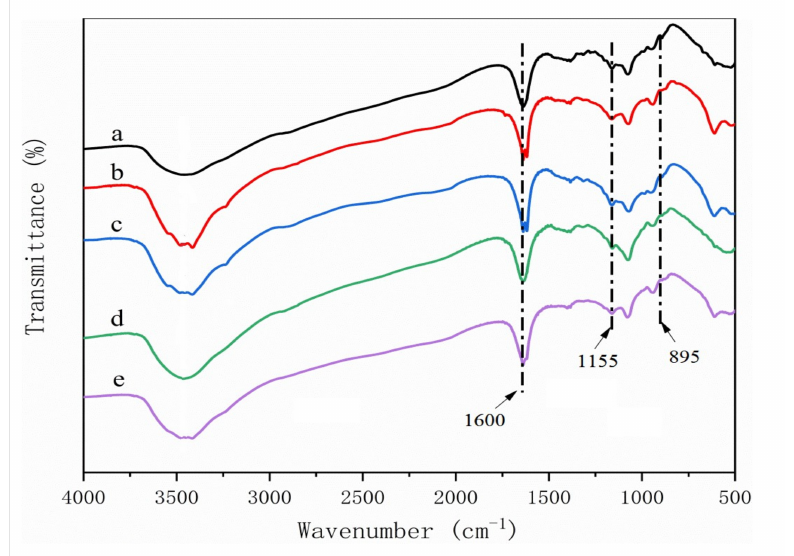
Figure 7. FTIR spectra of cellulose derived from ( a ) pine wood, ( b ) bamboo culm, ( c ) pine needles, ( d ), bamboo leaves, or ( e ) hemp hurd.